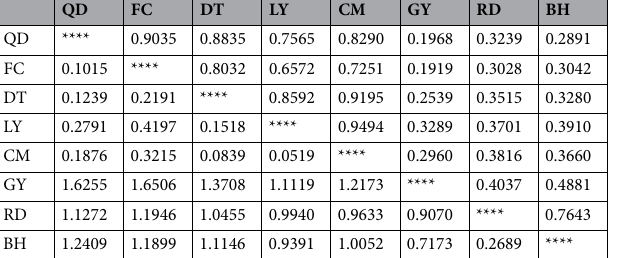
Table 4. Nei’s genetic identity (above diagonal) and genetic distance (below diagonal) for eight L. maculatus populations. LY Lieyu, CM Chongming, DT Dongtou, QD Qingdao, FC Fangcheng, GY Ganyu, RD Rudong, BH